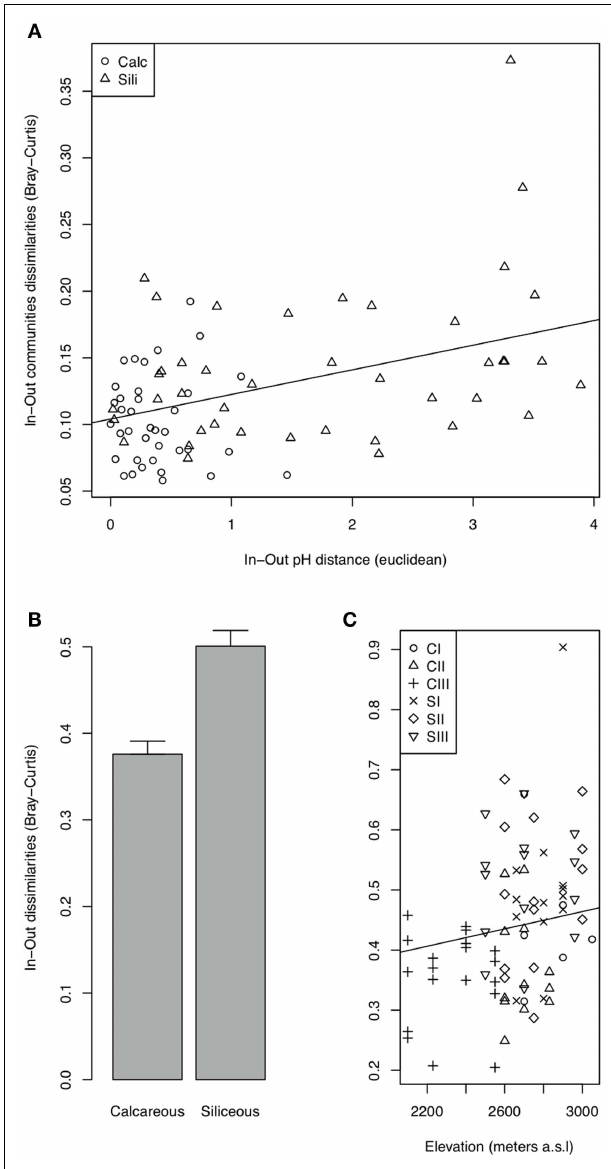
distribution of soil fungi (Manter et al., 2010). The response of bacteriaandfungitoabioticvariableswasstillsignificantaftercon- trolling for geographic distance, which supports the link